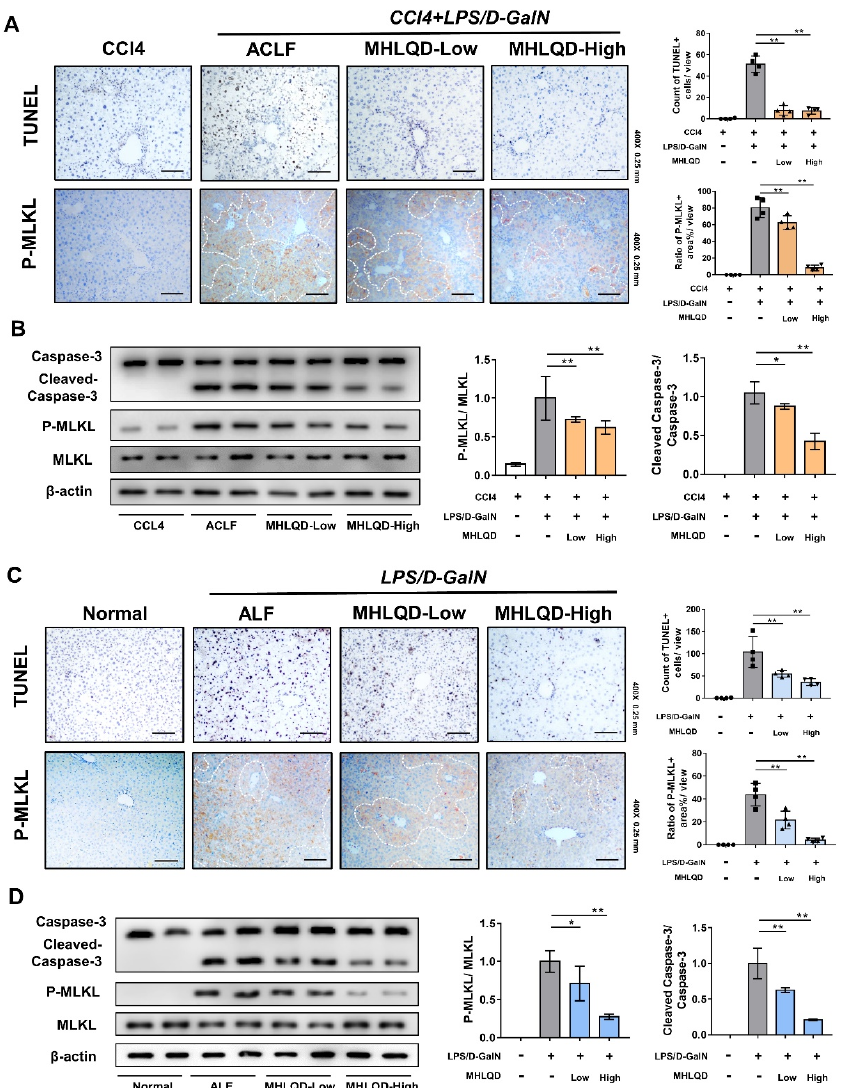
Figure 3. MHLQD suppressed hepatocyte necroptosis and apoptosis in ACLF and ALF mice. The mice were intraperitoneally injected with 320 mg/kg D − GalN and 30 ug/kg LPS to establish ACLF and ALF models. MHLQD or the same volume of PBS was orally administrated to mice 1.5 h before and 1.5 h after LPS/D − GalN injection. ( A ): The TUNEL staining and p-MLKL staining in liver tissues of ACLF mice. Scale bar: 0.25 mm. ( B ): The protein expression of Caspase-3 and p-MLKL/MLKL in liver tissues of ACLF mice. ( C ): The TUNEL staining and p-MLKL staining in liver tissues of ALF mice. Scale bar: 0.25 mm. ( D ): The protein expression of Caspase-3 and p-MLKL/MLKL in liver tissues of ALF mice. * p < 0.05, ** p < 0.01. Abbreviation: MHLQD: MaHuang-LianQiao-ChiXiaoDou decoction, ACLF: acute-on-chronic liver failure, ALF: acute hepatic